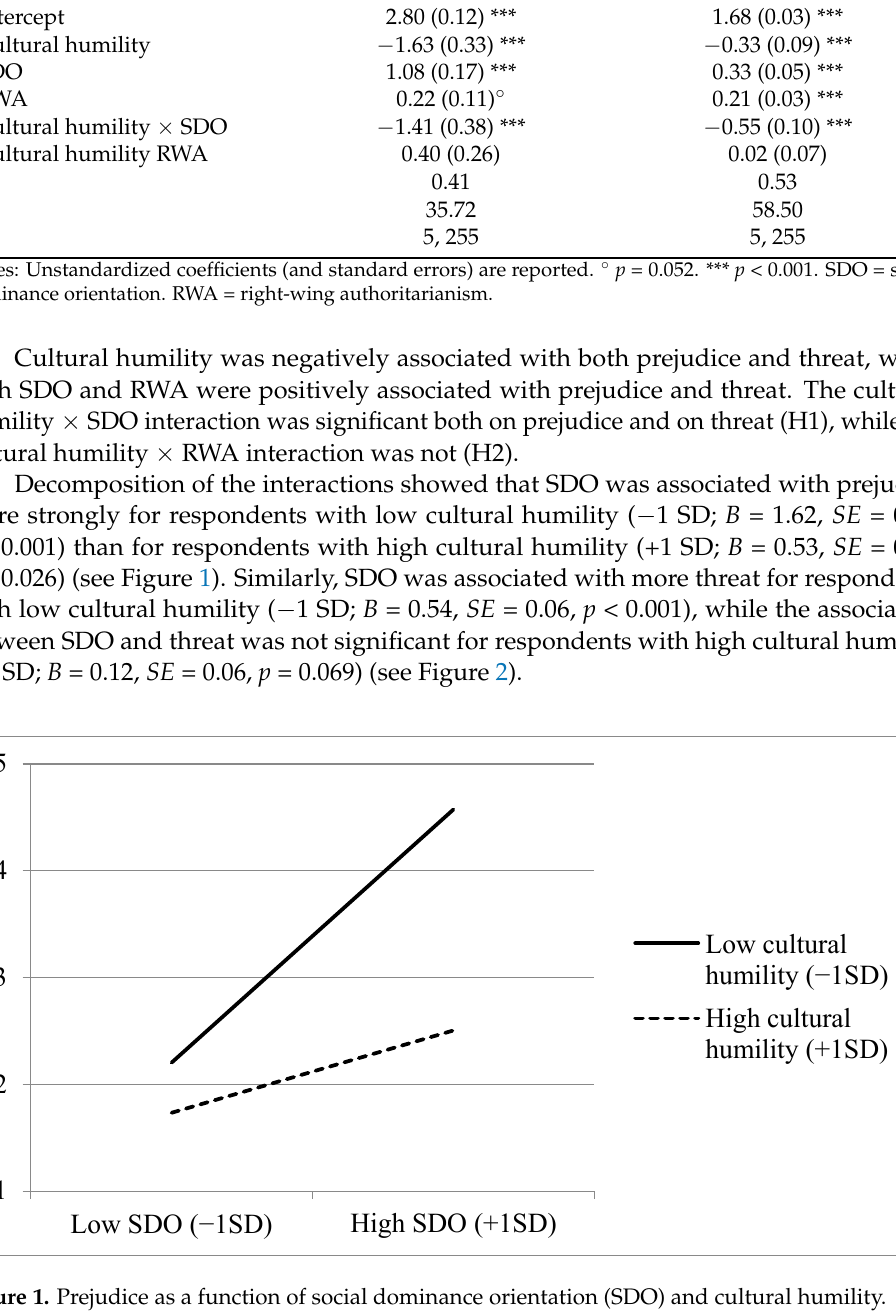
Figure 2. Perceived threat as a function of social dominance orientation (SDO) and cultural humil- ity. To check the robustness of these findings, the regression analyses were re-run con- trolling for intergroup contact, which covariates with both cultural humility [18] and with ideologies, e.g., [29], and for socio-demographic characteristics, i.e., gender, age, and ed- ucational level (gender was treated as dichotomous, i.e., male vs. female, and the partici- pant who declared a genderfluid gender identity was not included in these additional analyses; missing data on socio-demographic characteristics were not imputed, therefore n = 248). The results pattern did not change. 4. Discussion In a correlational study conducted in Italy, we tested whether cultural humility could shape associations between SDO and RWA on the one hand, and prejudice toward immi- grants and perceived threat posed by immigrants on the other hand. Supporting H1, we found that the associations of SDO with prejudice and with threat were lower among par- ticipants with high cultural humility compared to participants with low cultural humility. Conversely, cultural humility did not moderate associations between RWA and prejudice and threat, disconfirming H2.